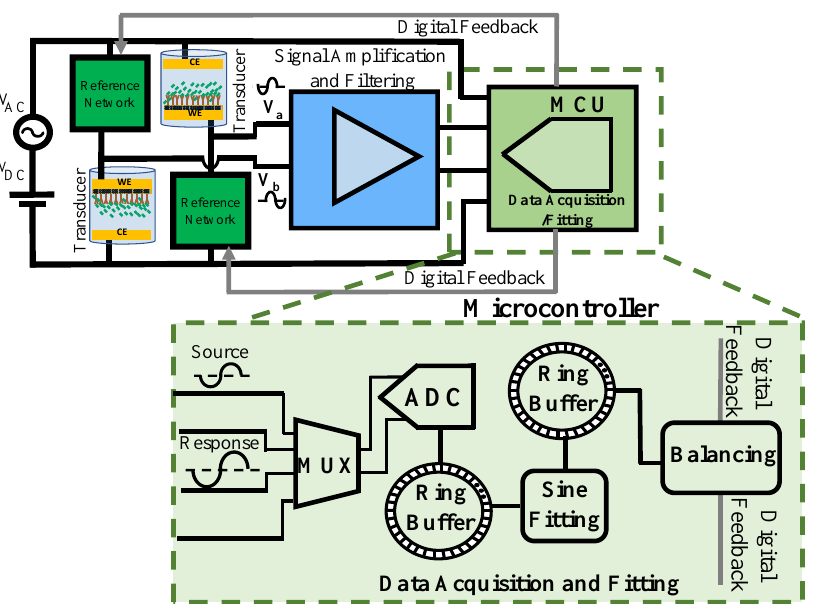
Figure 4. A single microcontroller is utilized to both digitize the source and response signals. The built-in ADC samples the source and response signals alternatively. The samples are stored in ring buffers, and MCU computes the amplitude and differential phase information. The results are stored in a ring buffer for external